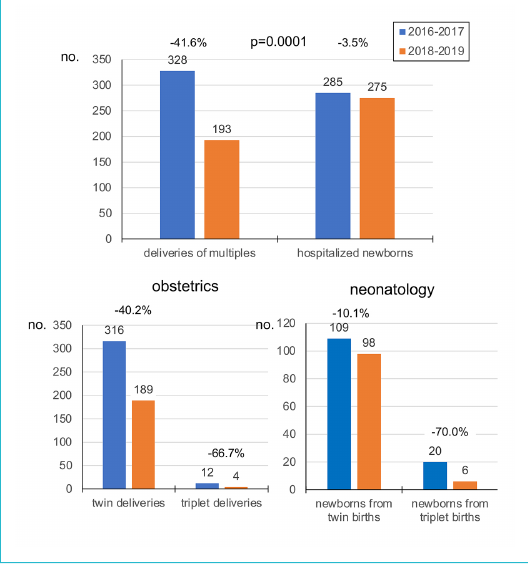
Figure 5: The impact of the embryo transfer policy in our institu- tion before and after the decision to transfer only one embryo in all ART treatments on the number of multiple deliveries in the depart- ment of obstetrics of the Women’s Hospital of the University and in the department of neonatology of the Children’s Hospital of the University. A decline in both twin and triplet deliveries, and twin and triplet newborns, is observed between the time periods 2016–2017 and